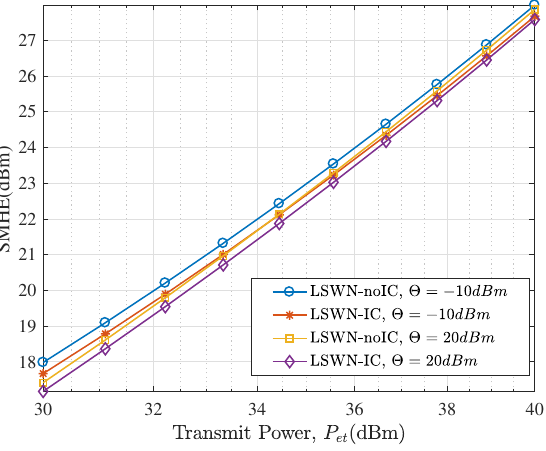
Figure 13. Spatial mean harvestable energy versus transmitter density with α = 4, d = 2, η a = 1 and λ t =